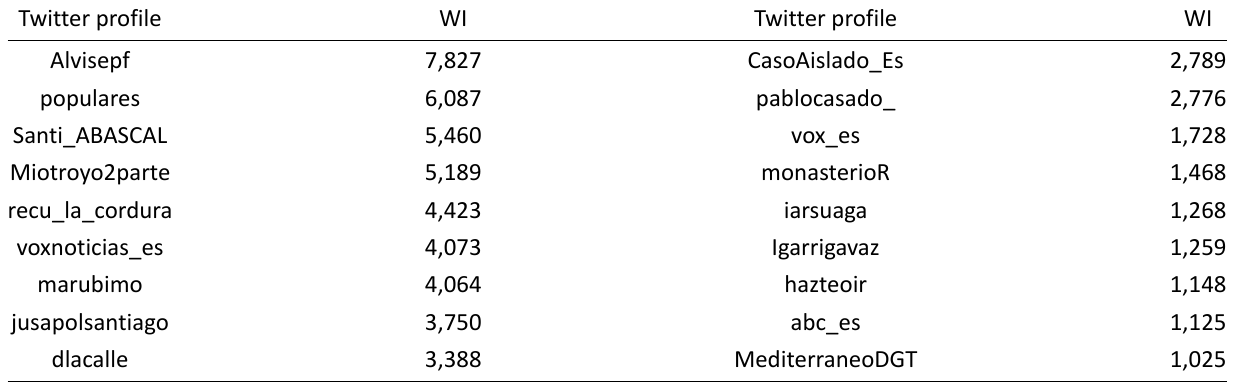
Table 2. Influencers in the VOX community with more than 1,000 retweets.